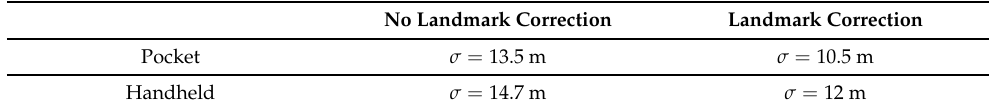
Table 2. Performance metrics of the smartphone localization systems for the pocket and handheld carrying modes before and after incorporating the landmark